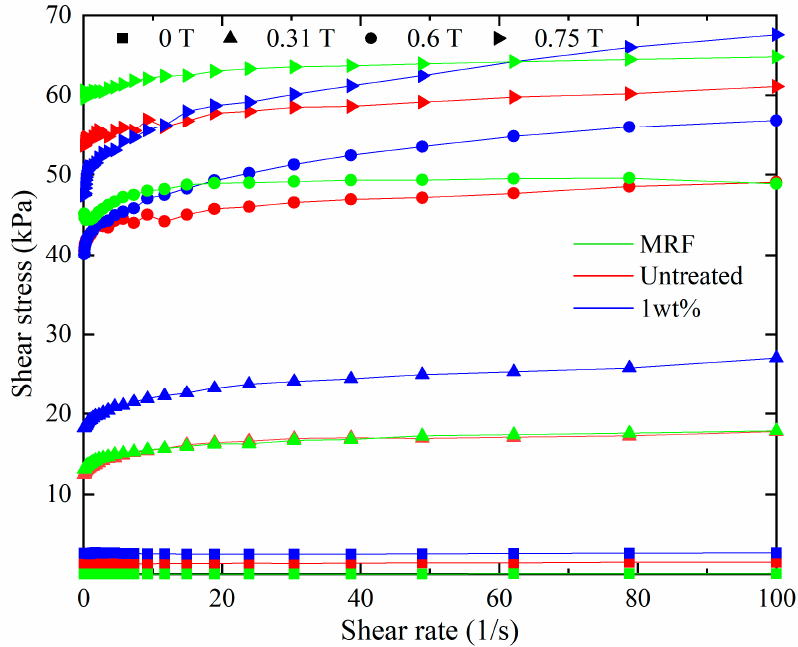
Figure 8. Comparison of shear stress between different